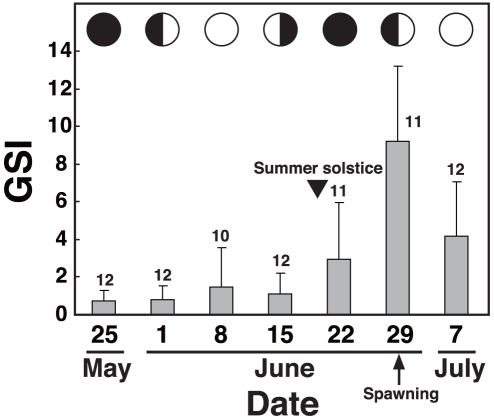
Temporal change in GSI values of the female goldlined spinefoot during the lunar reproductive cycle.Gonadosomatic index (GSI) was calculated as described in Materials and Methods. Numbers of fish sampled are indicated above the bars. An arrow and an arrowhead show the spawning and the summer solstice, respectively. Indicated by seven schematic images are lunar phases from new moon (May 25th, left) to full moon (July 7th, right).